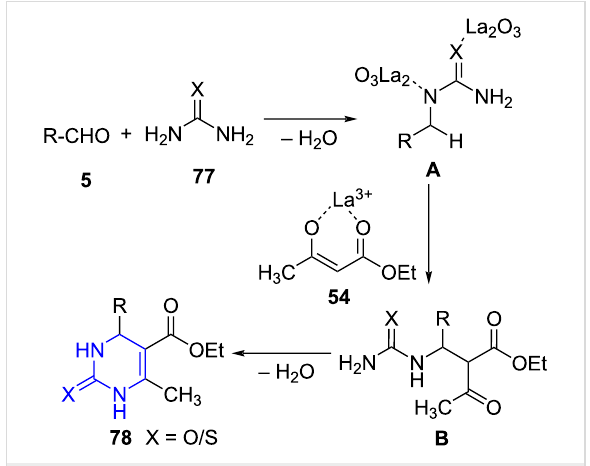
Scheme 29: Proposed mechanism for dihydropyrimidinones.